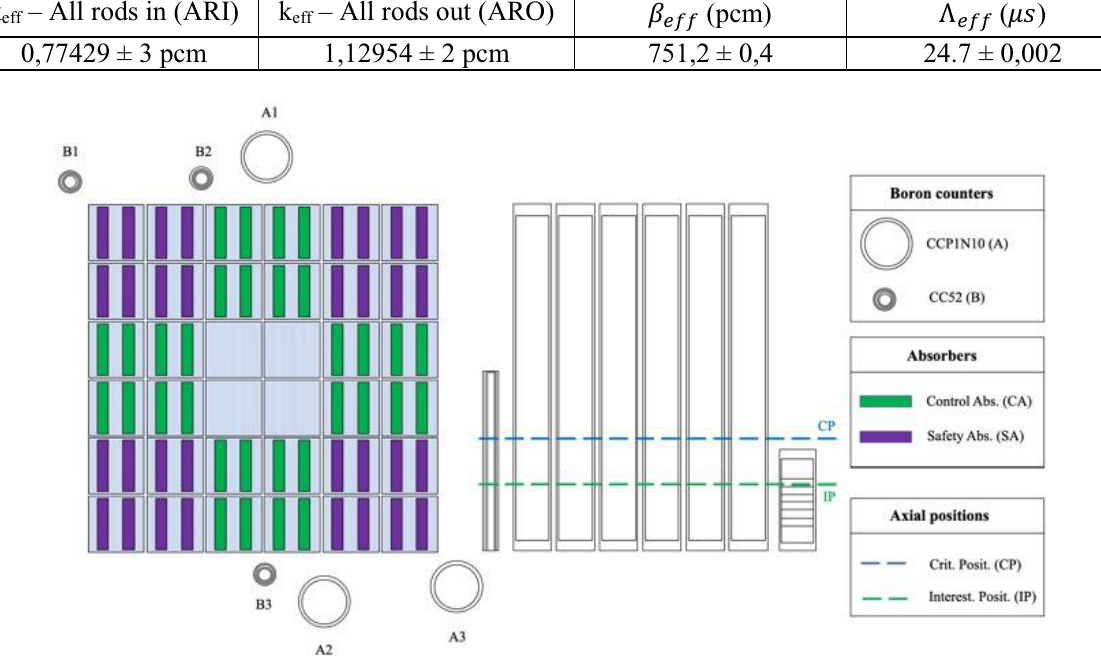
Figure 2 – Core loading with detectors and absorbers distribution - xy plane (left) and xz (right)